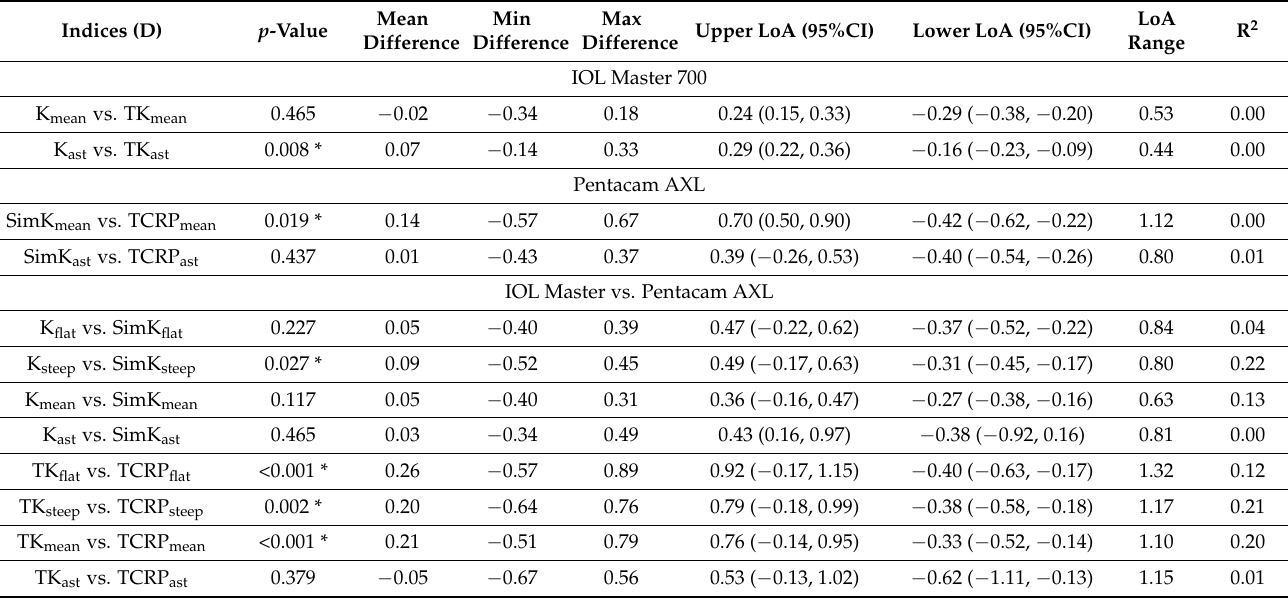
Table 3. Comparison of the IOL Master 700 and Pentacam AXL indices.